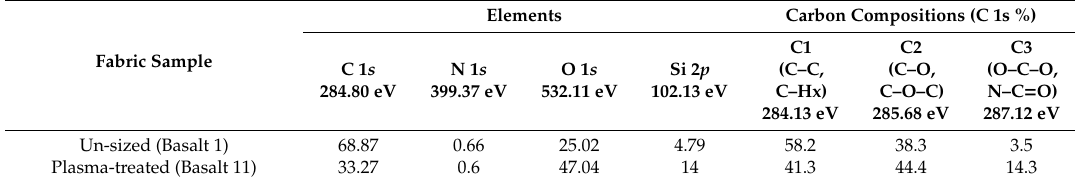
Table 4. Atomic concentration (%) of the elemental surface composition and relative atomic concentration of carbon for basalt fabrics treated with